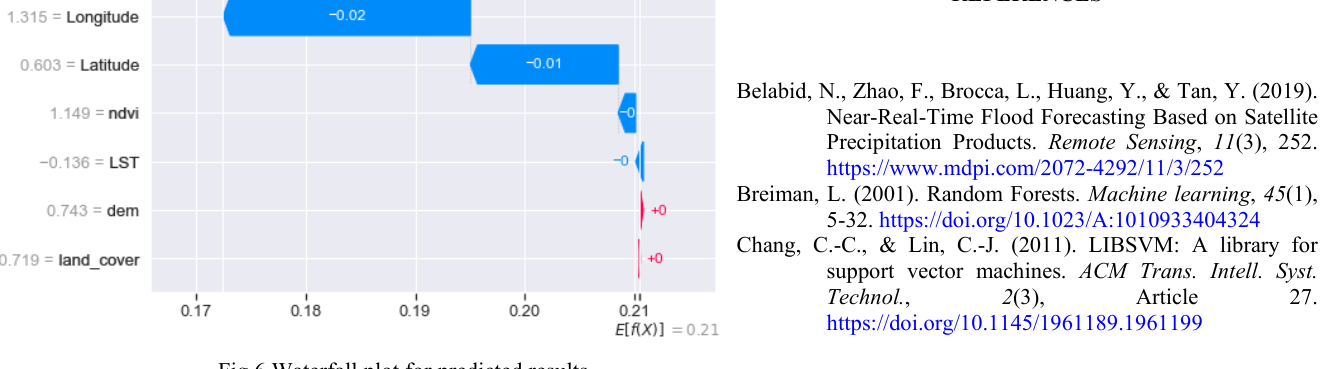
Fig.6 Waterfall plot for predicted